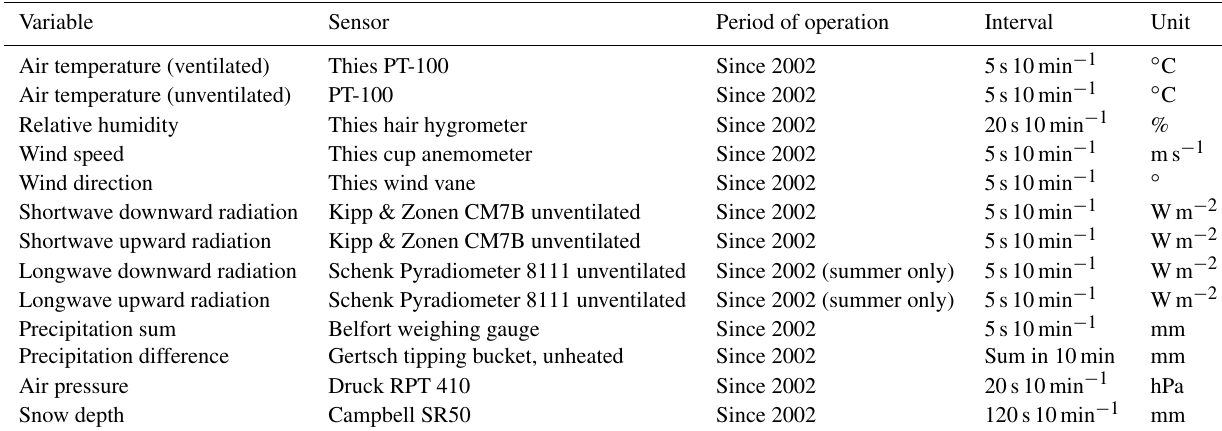
Table 3. Sensors and sampling intervals of the AWS Vernagtbach (2640ma.s.l., 46.85663 ◦ N, 10.82857 ◦ E) ∗